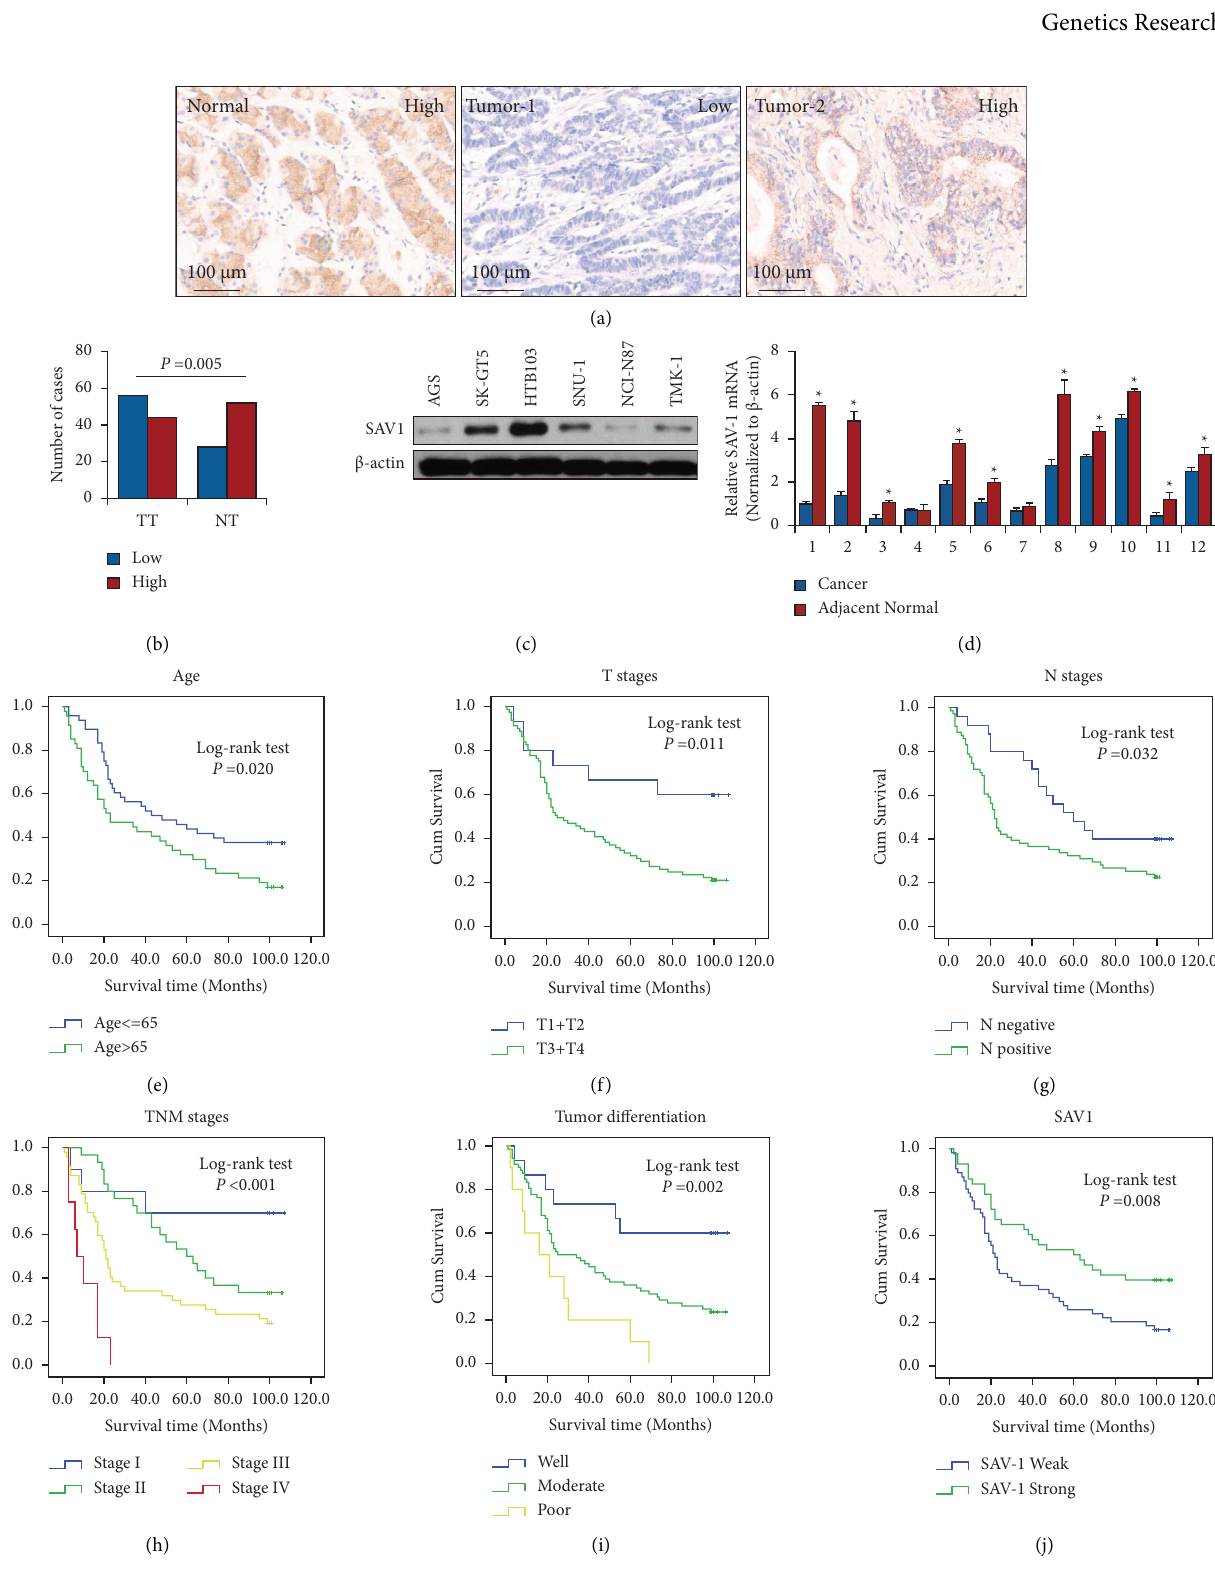
Figure 1: SAV1 expression and its correlation with the clinicopathological features of GC. Tissue microarray GC specimens were im- munostained with a specifc anti-SAV1 antibody. (a) Representative images of SAV1 expression in adjacent normal gastric tissues and GC tissues. Markedly high SAV1 expression was observed in adjacent normal tissue (normal, left panel), low SAV1 expression was observed in tumor tissue (tumor 1, middle panel), and high SAV1 expression was observed in tumor tissue (tumor 2, right panel). (b) SAV1 expression was signifcantly lower in tumors (TT) than that in adjacent normal tissue (TN). (c) SAV1 protein levels in GC cell lines. (d) Te mRNA levels of SAV1 in 12 paired GC and adjacent normal gastric tissues were measured using reverse transcription-quantitative PCR. (e) Age of > 65years ( P � 0 . 020), (f) invasion depth ( P � 0 . 011), (g) lymph node metastasis ( P � 0 . 032), (h) clinical stage (TNM stage) ( P < 0 . 001), and (i) poorer tumor diferentiation ( P � 0 . 002) were negatively associated with the OS of patients with GC. (j) SAV1 expression was positively associated with the OS of patients with GC ( P � 0 . 008). SAV1, Salvador homologue 1; GC, gastric cancer; OS, overall